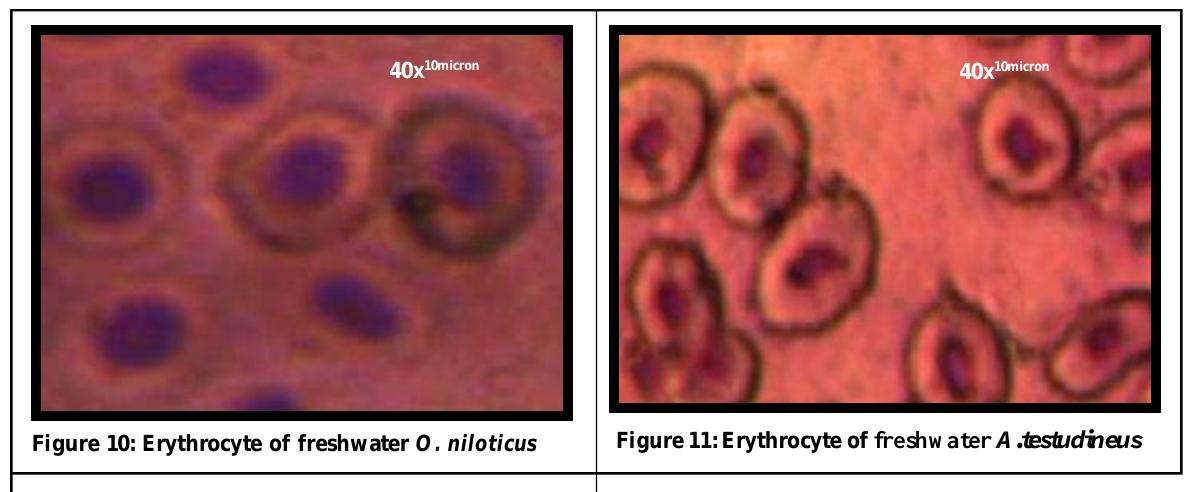
The cell breadth of erythrocyte shows higher value in Labeo rohita (8.68±0.18) and lower in Anabas testudineus (6.82±0.24). Sex wise significant difference in cell breadth is recorded in Clarias batrachus (males = 7.09±0.19 and females = 8.19±0.14), Channa punctatus (males = 7.09±0.19 and females = 8.19±0.14) and Anabas testudineus (males = 8.03±0.20 and females = 6.82±0.24) at P < 0.001. It is noted that area of erythrocytes reflects higher value in Cirrhinus mrigala (8.30 ±0.10) and lower in A nabas testudineus (8.30 ±0.10), but sex wise significant difference of Figure 12: Erythrocyte of freshwater N. notopterus erythrocyte area is found only in Clarias batrachus (males = 49.27±2. 07 and females = 62.04±1.72), Cirrhinus mrigala (males = 8.03±0.20 and females = 6.82±0.24), Channa punctatus (males = 8.03±0.20 and females = 6.82±0.24) and Anabas testudineus (males = 62.75±2.38 and females =